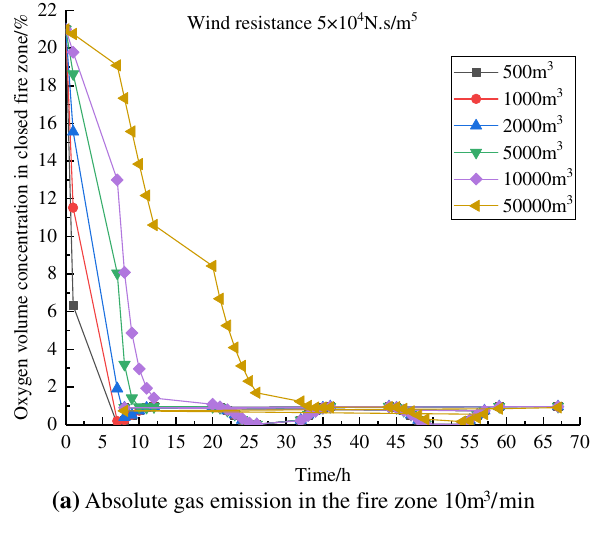
(a) Absolute gas emission in the fire zone 10m 3 /min